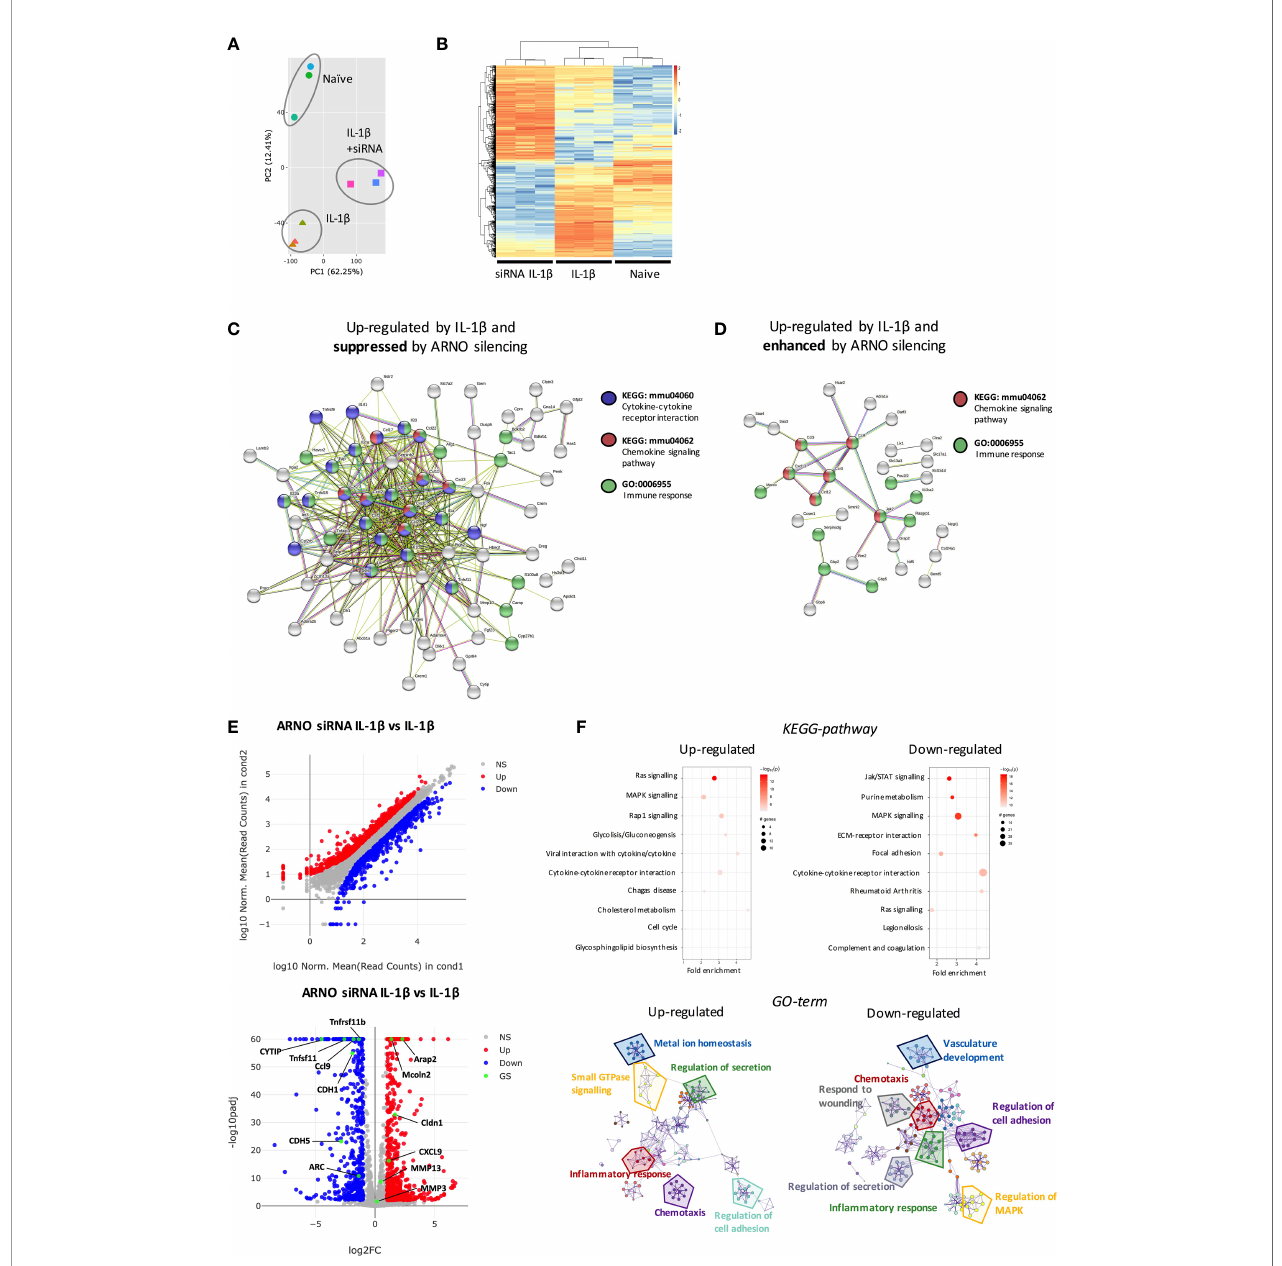
FIGURE 5 | ARNO knocked-down SFs show a distinct transcriptomic pro fi le in response to IL-1 b stimulation. (A) RNA was isolated (RIN>9) from naïve, IL-1 b stimulated and IL-1 b stimulated ARNO knocked down SFs (6 hours, n=3) and subjected to bulk RNA-Seq (75bp paired-end, 30M reads). Principal component analysis (PCA) is shown. (B) Differential expression (DE) of genes amongst the three experimental groups. Genes were considered signi fi cant if they passed a threshold of padj < 0.01 and |log2foldChange| > 4 among any paired comparison. DE genes were then subjected to unsupervised hierarchical clustering and represented as Z scores. (C,D) Function enrichment and network analysis regulated by IL-1 b and ARNO expression. STRING protein-protein interaction network (https://string-db.org) was performed on DE genes from (B) , with genes up-regulated only in the IL-1 b -treated group (C) or genes up-regulated only in the ARNO siRNA group (D) . Signi fi cantly modulated pathways components associated with ARNO silencing upon IL-1 b are shown. (E) DE of genes in IL-1 b stimulated SFs compared to ARNO siRNA IL-1 b SFs. Genes are plotted as a scatter plot where x= gene expression in IL-1 b SFs, y=gene expression in siRNA ARNO IL-1 b SFs. Volcano plot shows gene expression versus p value for each gene. Genes that pass a threshold of padj < 0.01 and |foldChange| > 2 in DE analysis are colored in blue when they are down regulated and red when they are upregulated in IL-1 b treated cells. (F) DE genes identi fi ed in (E) were used to conduct KEGG pathway enrichment analysis and GO-term pathway analysis. KEGG pathways are represented by circles and are plotted according to fold enrichment on the x-axis and -log10 p-value on the coloured scale. The size is proportional to the number of DE genes. Metascape enrichment network diagrams illustrate GO-term pathways signi fi cantly enriched for top up-regulated and down-regulated